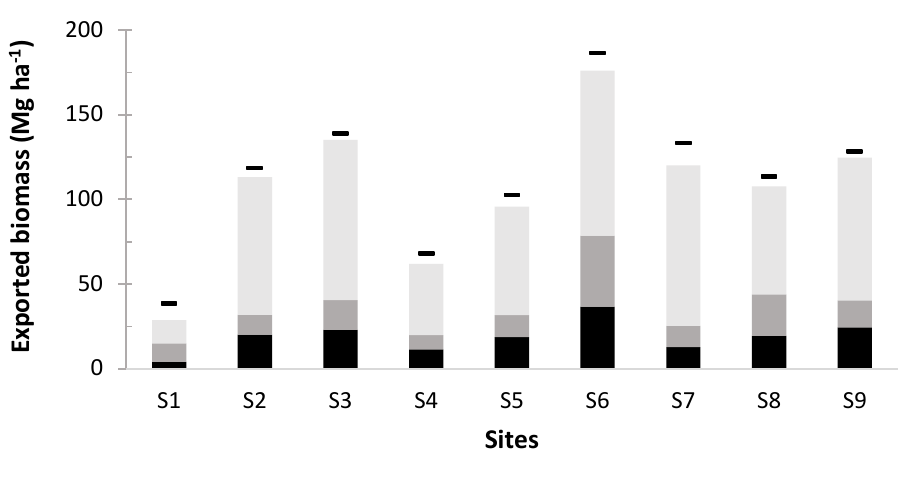
Figure 4. Representation of exported biomass by wood diameter classes and comparison to total harvested biomass.